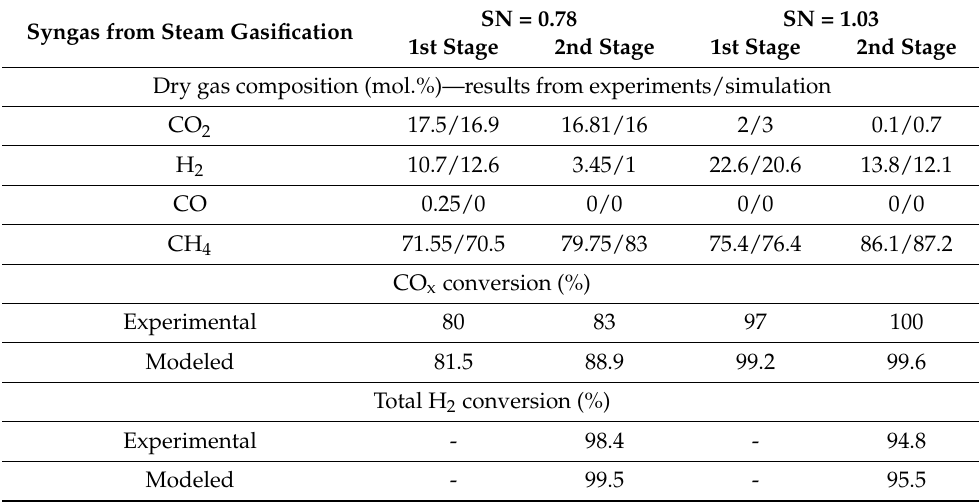
Table 7. Large-scale power-to-gas concepts following the methanation strategies for the chosen gasification product gas compositions (assumed constant biomass input of 25 MW).